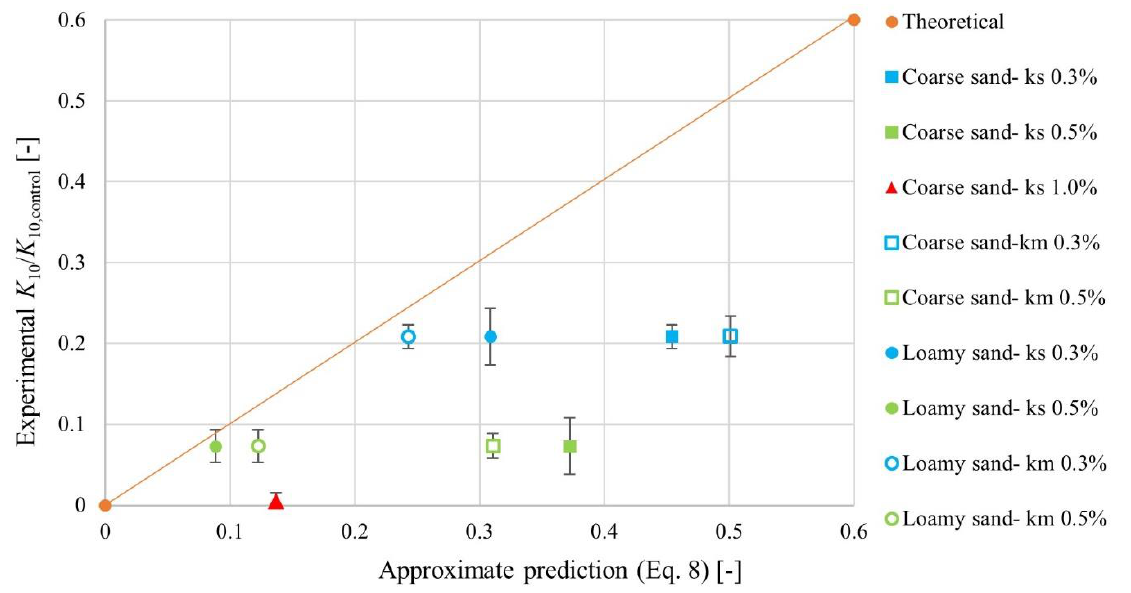
Figure 7. Comparison between experimental measurements and the theoretical prediction of Equa- tion (8). The vertical axis shows the long-time coefficient of permeability K 10 obtained by averaging the last 20 min of each test and normalized by the corresponding value for the SAP-free control case, K 10,control . The horizontal axis shows the corresponding theoretical prediction. The two agree to within a factor of ~3.